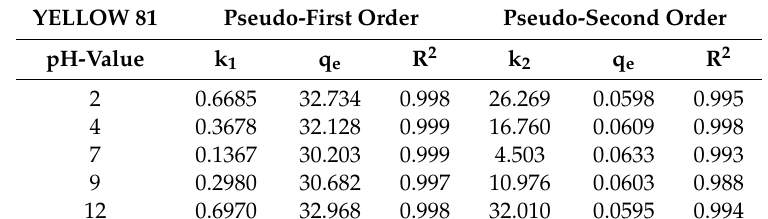
Table 4. Return of kinetic model data for Reactive Yellow 81.